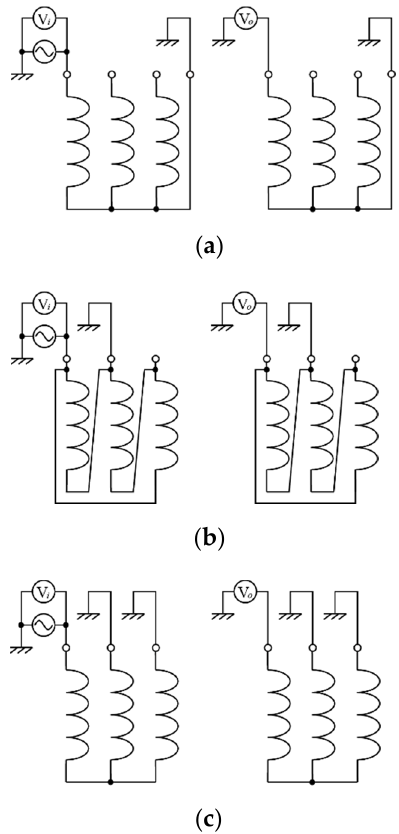
Figure 2. IIW measurement in FRA: ( a ) YNyn0, ( b ) Dd0, and ( c ) Yy0.